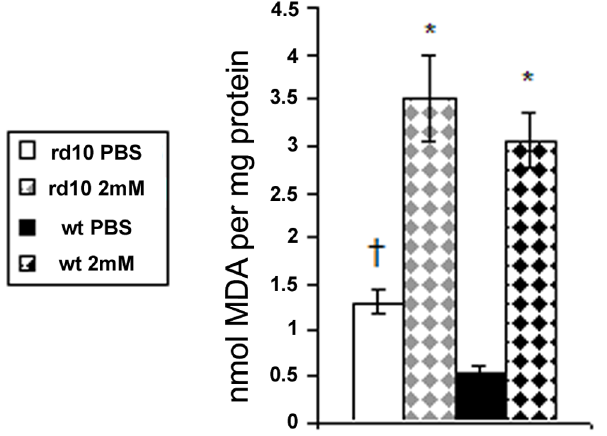
Figure 5. Measurements of TBARS level in mice retinas following PQ injection. TBARS level (nmol MDA per mg protein) indicates the extent of oxidative injury to lipids. TBARS were measured in retinas of rd10 and WT mice following 2 mM paraquat or PBS injections. *p # 0.004 as compared to PBS injected eyes of same strain. { p=0.001 comparing control (PBS) eyes between the strains (n=5 in each group).